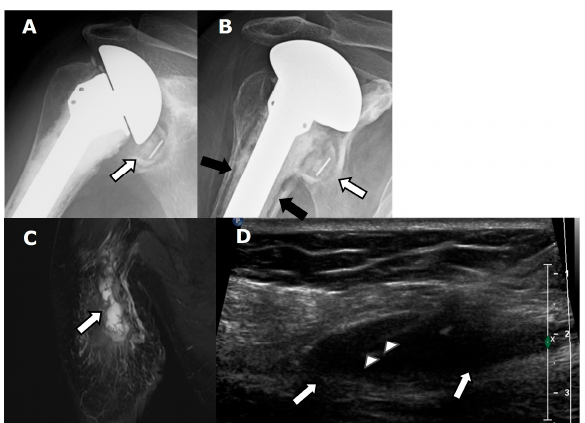
Figure 12. Patient with ATSA and periprosthetic joint infection in a patient with shoulder pain. ( A ). Frontal radiograph shows an ATSA with a small amount of lucency (arrow) around the glenoid component. ( B ). Frontal radiograph obtained several months later shows worsening lucency (white arrow) along the glenoid component, with new lucency (black arrows) along the bone–cement interface of the humeral component. ( C ). Coronal T2-weighted, fat-saturated MR image shows lobulated high signal (arrow) throughout the shoulder musculature. ( D ). Long-axis ultrasound (US) image shows an ovoid soft tissue fluid collection/abscess (arrows), with needle (arrowheads) present during diagnostic aspiration.